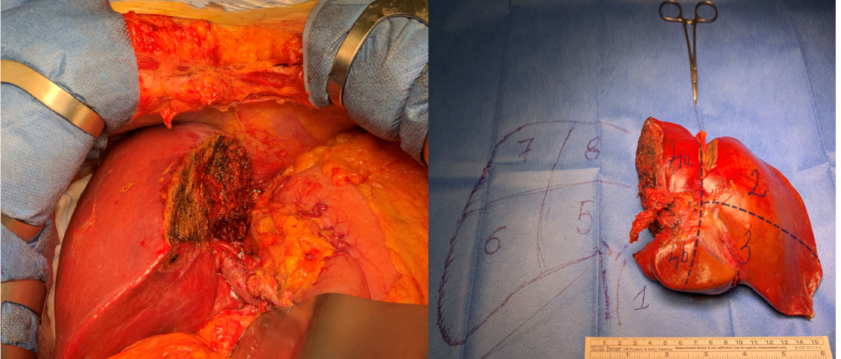
Figure 1. Left hepatectomy with caudate lobe resection for perihilar cholangiocarcinoma (pCCA) (Bismuth